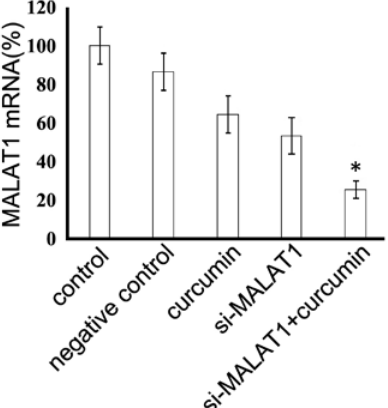
FIGURE 5 - The effect of curcumin on the expression of lncRNA-MALAT1 in the human colon cancer SW480 cells. Mean ± SD. n =3 . * P <0.05 vs other